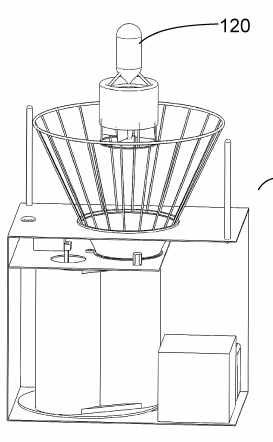
Figure 35. Ducted fan unmanned aerial vehicle docking station [90].